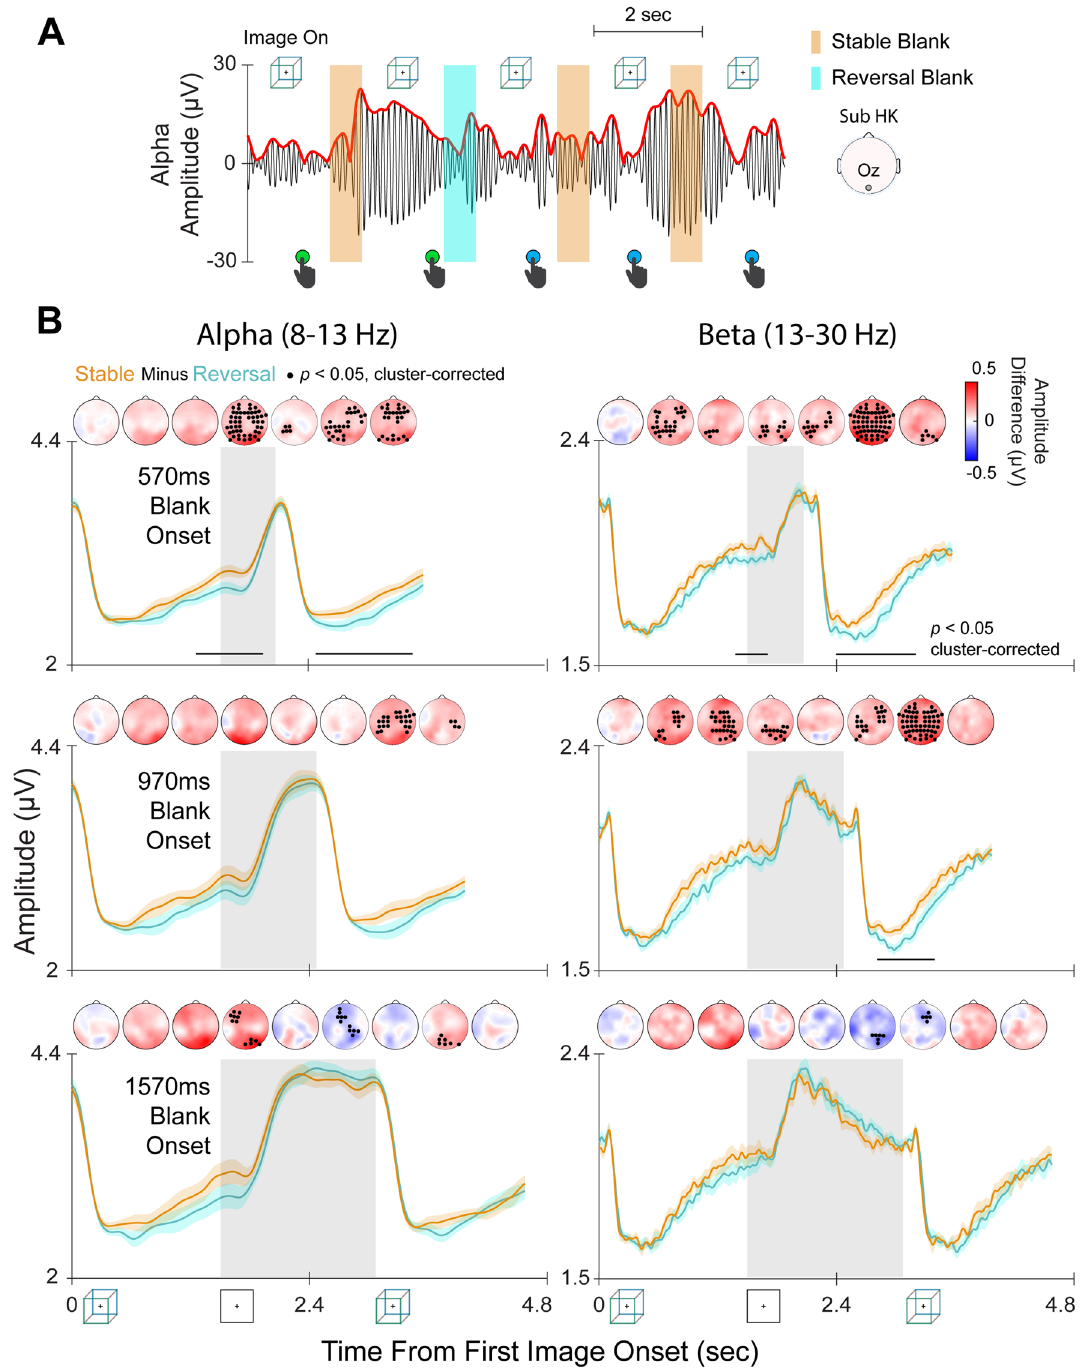
Figure 4. Alpha and beta amplitudes are higher in stable trials than in reversal trials. ( A ) An example EEG recording over 10 s of intermittently viewing the Necker cube (black curve is signal filtered in the alpha band and red curve is its amplitude envelope). Colored areas indicate blank periods; white areas indicate image presentation periods (1.5 s each) Green and blue button press symbols indicate reported perceptual switches to perceiving a green-fronted or blue-fronted cube, respectively. Each blank period was labeled a stable or reversal trial based on whether percepts before and after the blank period were the same or different. ( B ) Curves show alpha ( Left ) and beta ( Right ) amplitudes averaged across all channels for stable blank periods (orange curves) and reversal blank periods (cyan curves) (shading shows fixed-effects s.e.m.). Gray shaded areas indicate blank periods; white areas indicate image presentation periods (1.5 s each). Horizontal black bars indicate time periods of significant difference between stable and reversal trials (cluster-based permutation test, p < 0.05, two-tailed). Topo-plots show differences in band-limited amplitude (stable minus reversal trials) using 500 ms bins. Black dots indicate channels with significant differences between stable and reversal trials (cluster-based permutation test, N = 23, p < 0.05, two-tailed). Only data for cube trials are shown here (see Fig. S4 for face-vase